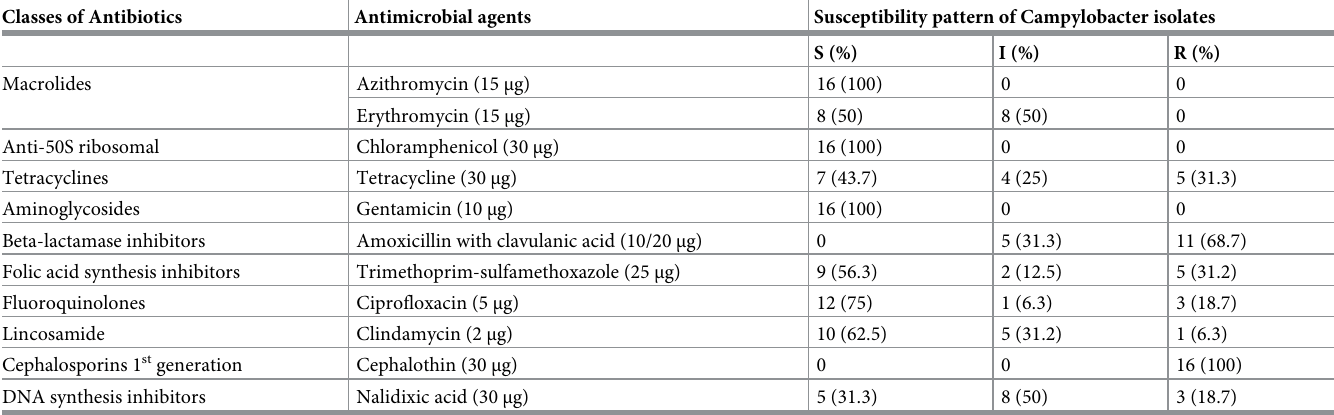
Table 5. Antimicrobial susceptibility pattern of Campylobacter among under-five children at Hawassa.